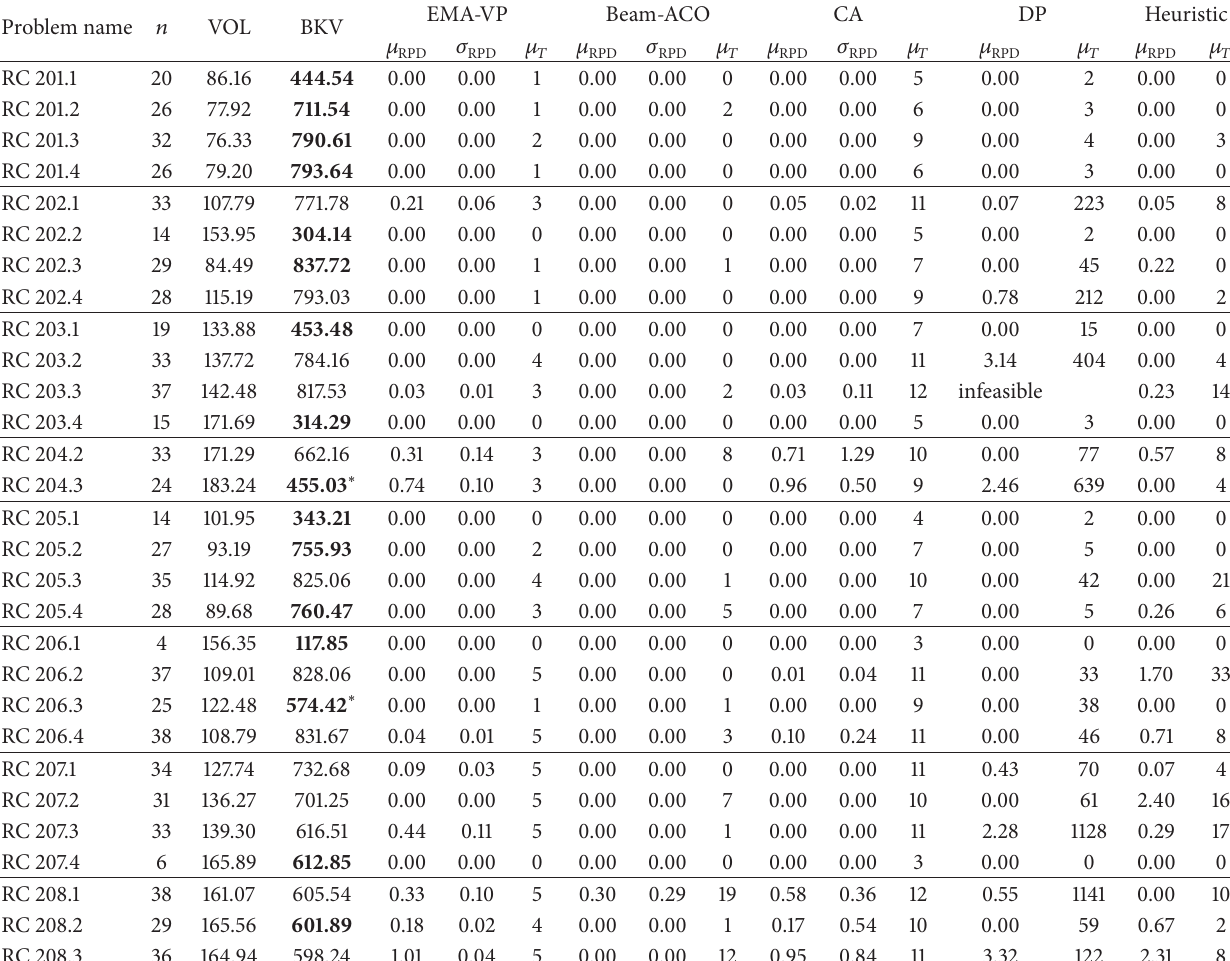
Table 4: Computational results on benchmark Set 1.